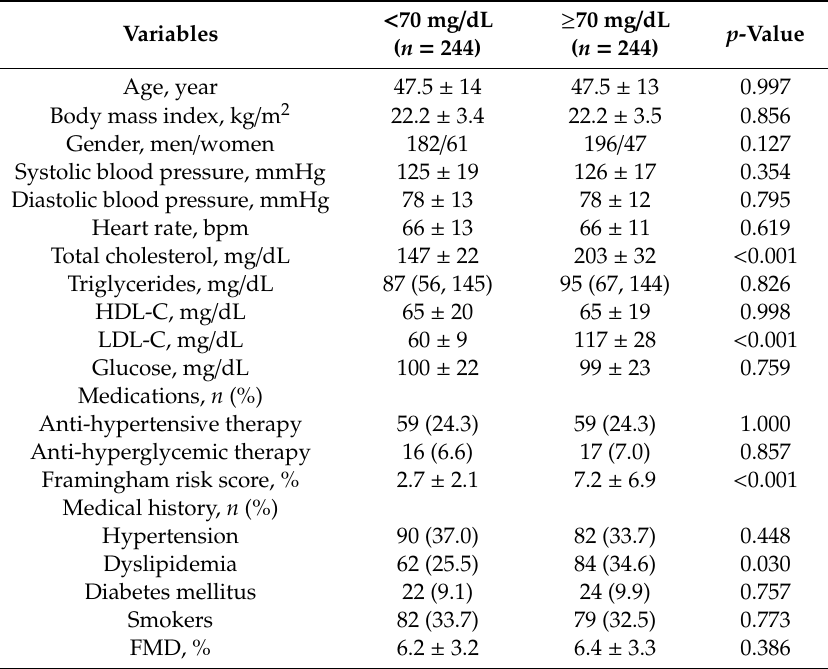
Table 3. Clinical characteristics in propensity score-matched